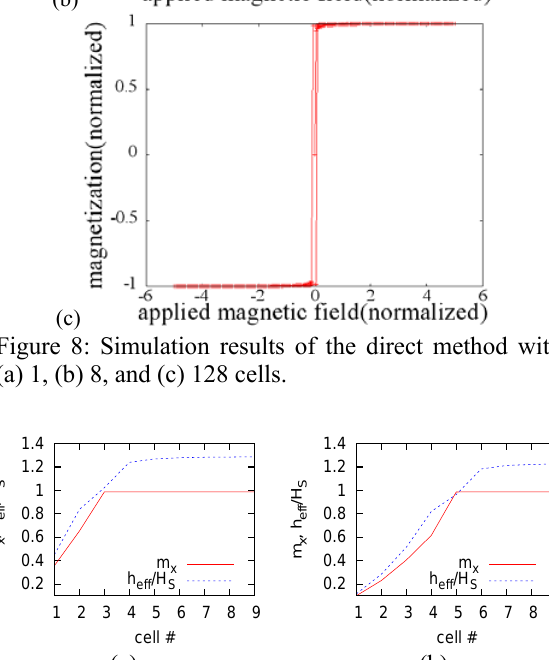
Figure 9: Distribution of m x and h eff in the original ADSM with 128 cells: (a) h = 0 and (b) h = 